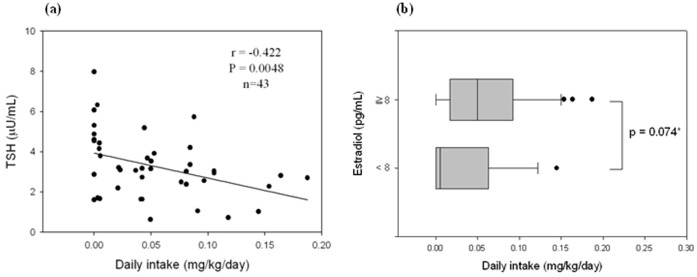
The relationship between daily intake (mg/kg/day) of affected foods and selected endocrine hormones.a) Spearman correlation between daily intake of affected foods and serum thyroid-stimulating hormone (TSH); b) median daily intake dichotomized by analytical sensitivity (8 pg/mL) of serum estradiol (E2) levels (*Mann-Whitney U test).